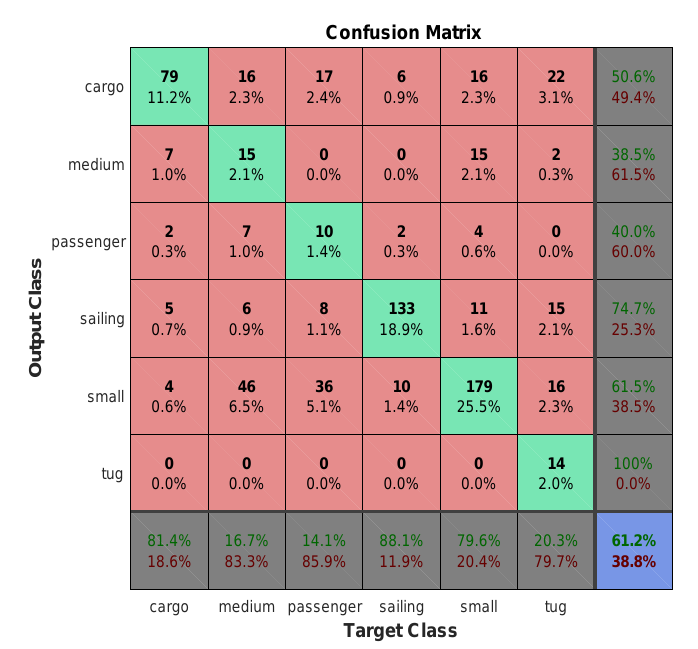
Figure 7. The confusion matrix of our best approach (CONV_3 features, large